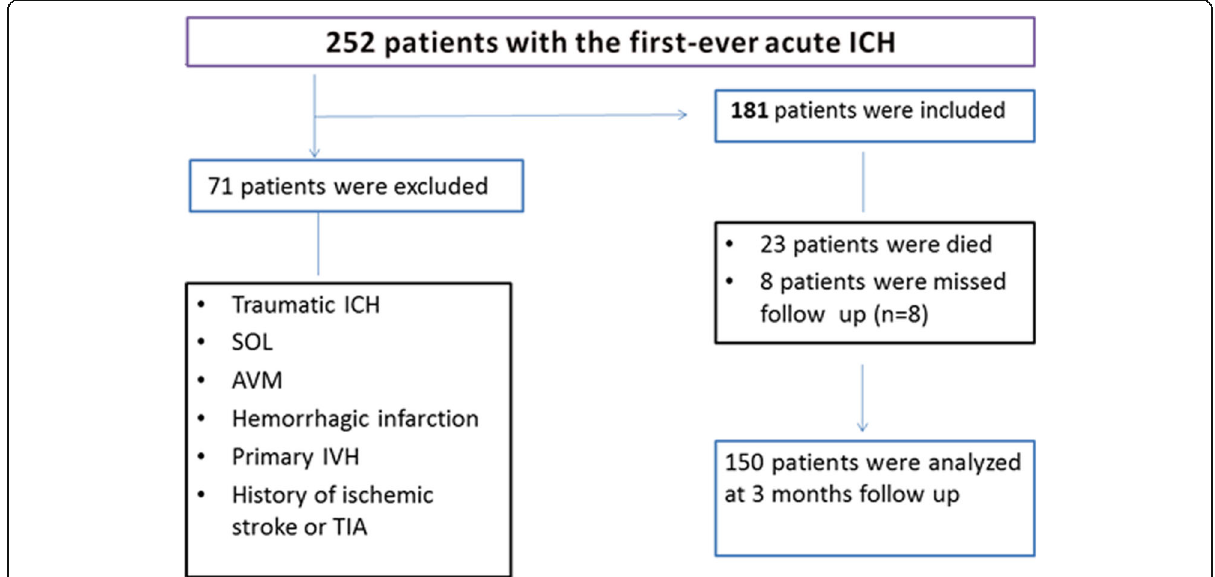
Fig. 1 Study flowchart showing the number of patients included in the final